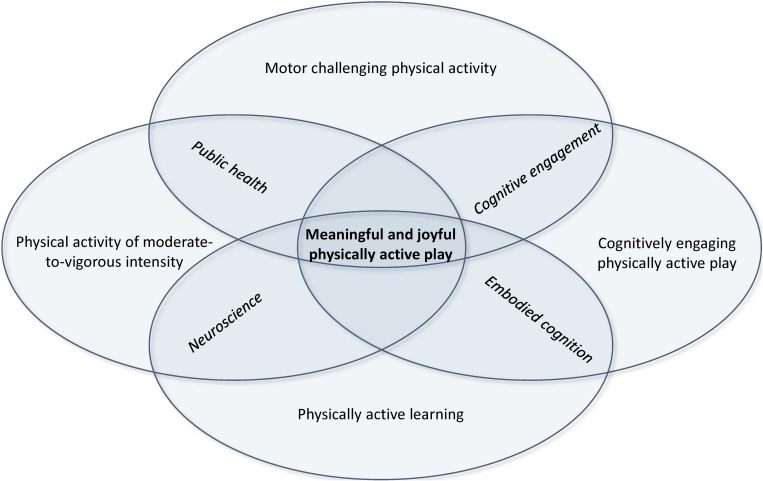
The intervention model at the child level.